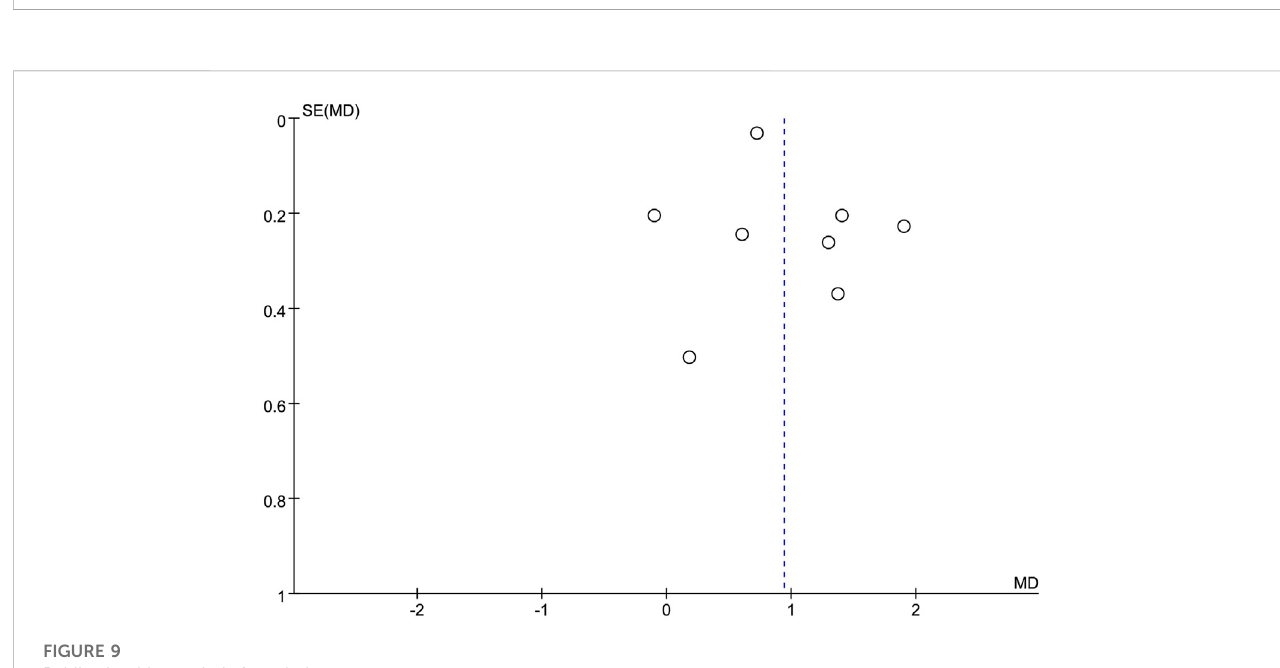
FIGURE 9 Publication bias analysis funnel